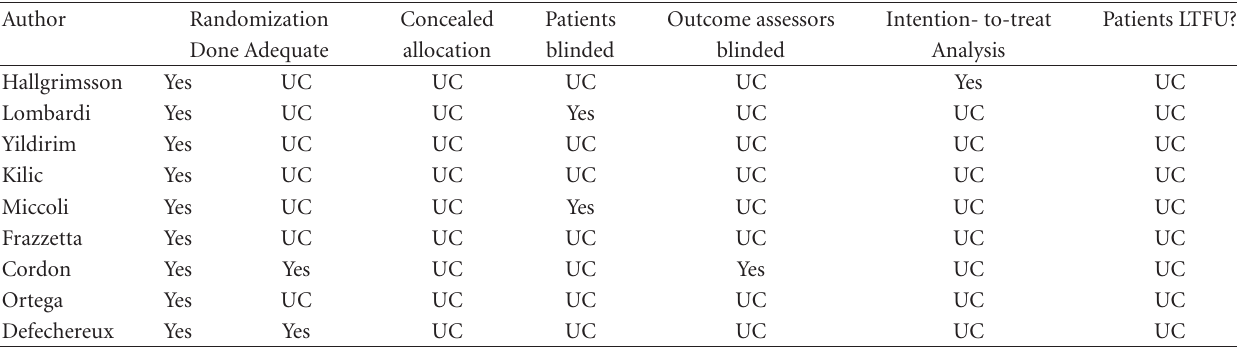
Table 2: Study validity.